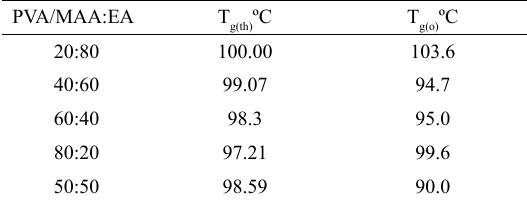
of the blends. g(th)